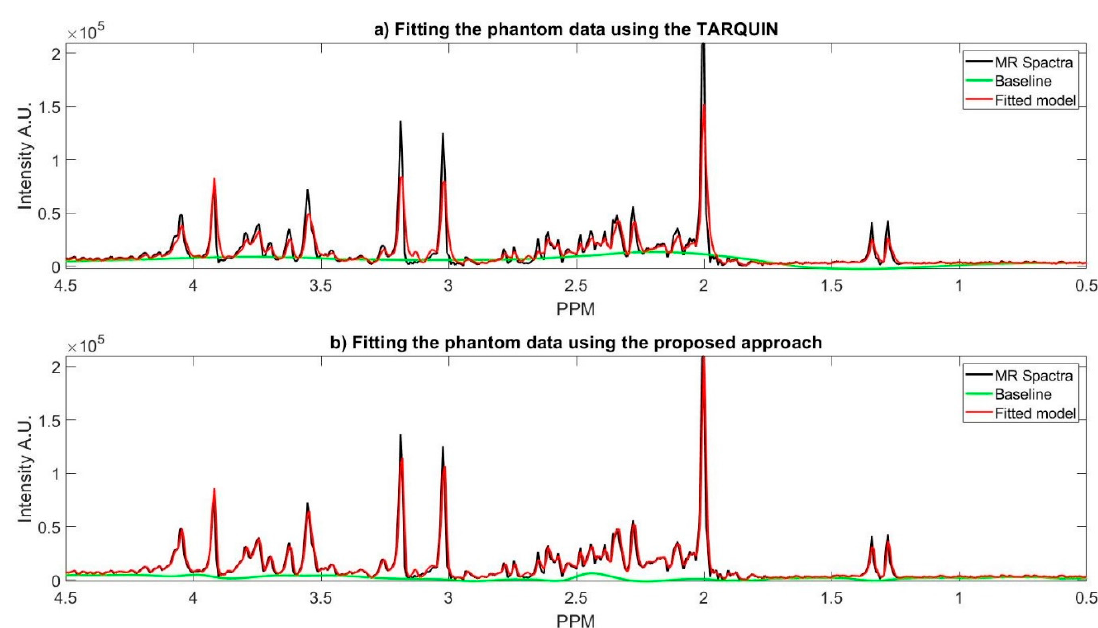
Figure 4. ( a ) The fitting phantom data magnetic resonance (MR) spectra using the TARQUIN; ( b ) The phantom data MR spectra fitted using the proposed approach. For both figures the phantom MR spectra (black), the fitted model (red), and the estimated baseline (green).